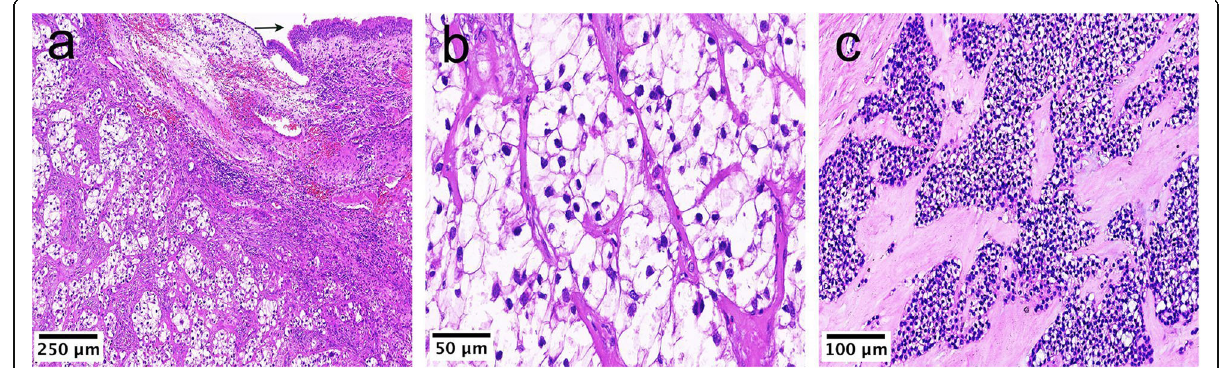
Fig. 2 The typical histological morphology for CCC. ( a ) Ciliated columnar epithelium of the respiratory tract is observed at the upper right margin (arrow). The CCC was located beneath the mucosa (Case 2, HE × 100). ( b ) Tumors were typically composed of oval, round, and polygonal cells with clear cytoplasm, arranged in nests or sheets, surrounded by fibrocellular stroma (Case 2, HE× 400). ( c ) In the conventional low-grade region of the HGT case, nuclei were uniform and small, round or oval, and had irregular, indented contours with finely dispersed or dark condensed chromatin (Case 1, HE×